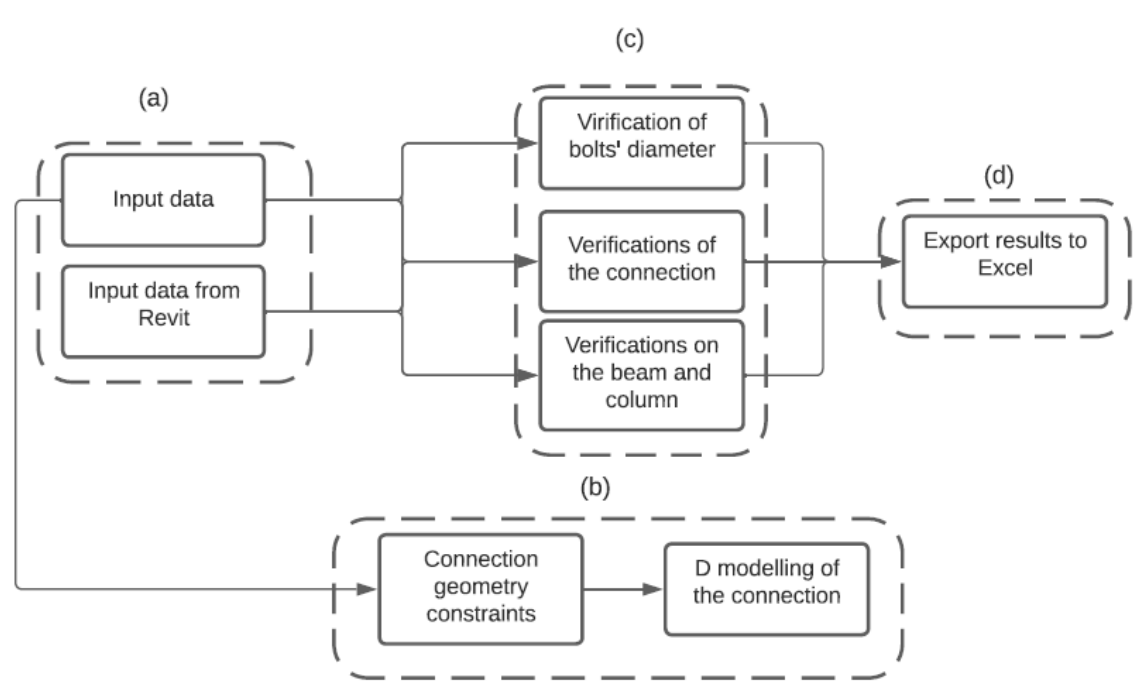
Figure 5. Script outline. Source: the authors.